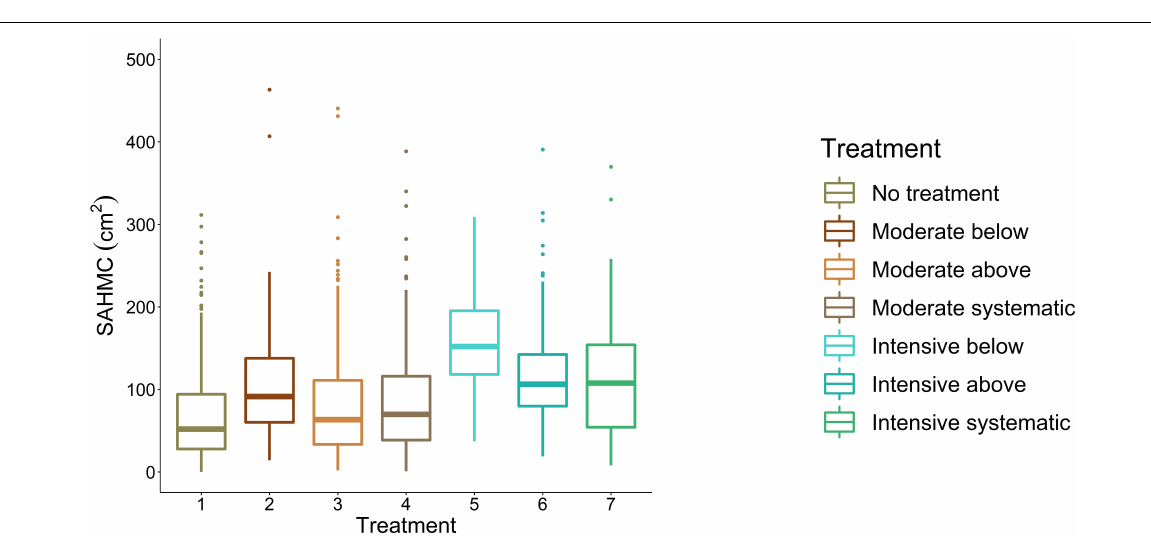
FIGURE 7 | SAHMC between thinning treatments. 1, no treatment (i.e., control); 2, moderate thinning from below; 3, moderate thinning from above; 4, moderate systematic thinning from above; 5, intensive thinning from below; 6, intensive thinning from above; and 7, intensive systematic thinning from